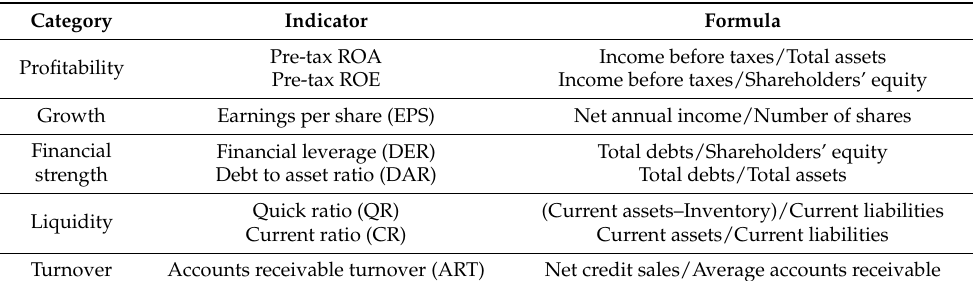
Table 1. Indicators